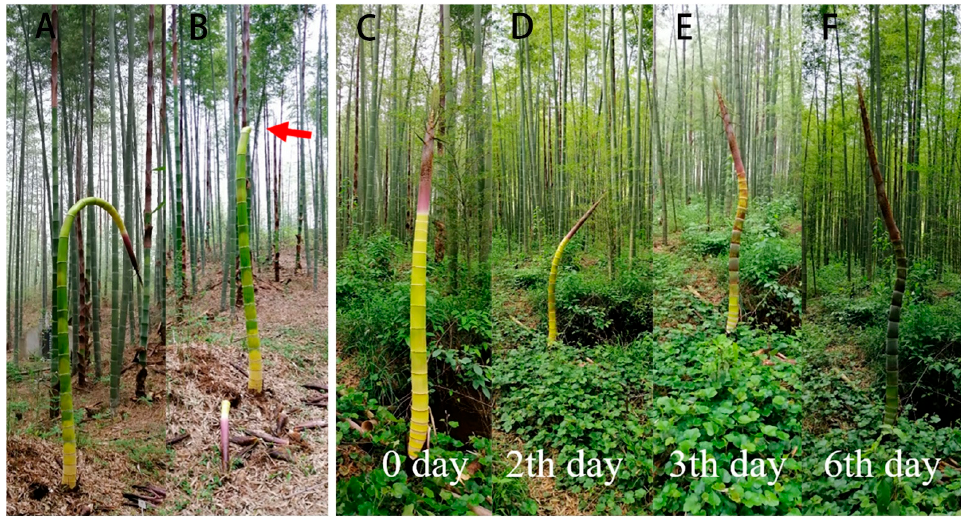
Figure 7. Stripped culm sheaths of bamboo shoots. ( A , B ) The upper part of the bamboo shoot after stripping was bent and broken. ( C – F ) Ensuing structural changes of a bamboo shoot over a 1-week period after stripping the sheath. The red arrow shows where the bamboo shoot has broken off.